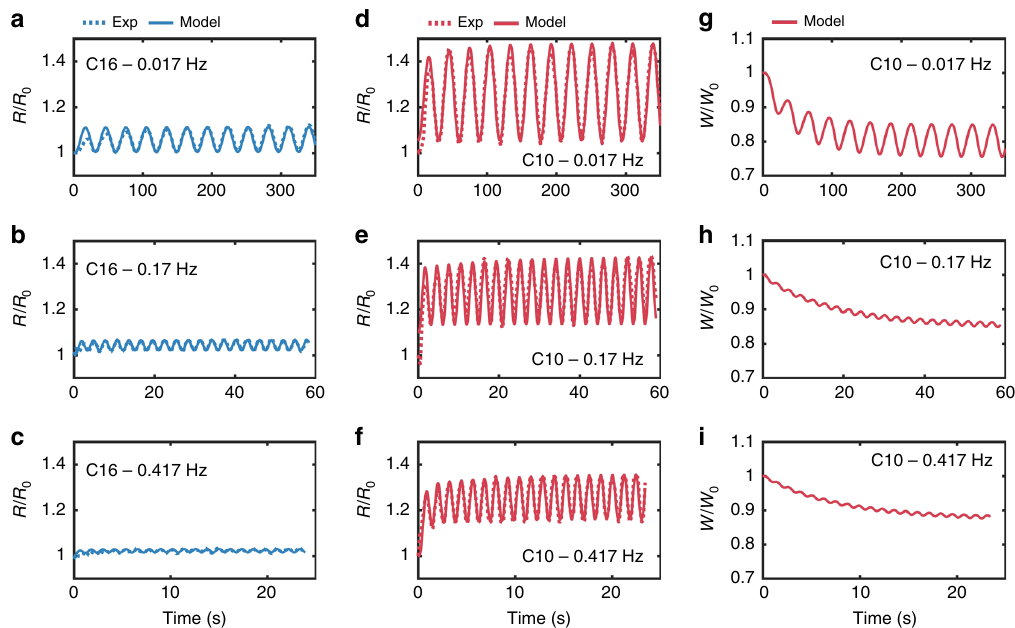
Fig. 6 Experimental and simulated changes in bilayer radius and thickness in response to sinusoidal voltage input. The fi rst two columns show measurements and simulated (obtained using Eq. 3) responses of dynamic changes in the radii of DPhPC membranes formed in both hexadecane ( a – c ) and decane ( d – f ) systems in response to sinusoidal voltages at three different frequencies. The third column ( g – i ) shows simulated (obtained using Eq. 4) dynamic changes in membrane thickness for a DPhPC membrane formed in decane. Experimental values of dynamic changes in thickness are not obtained; therefore, only simulated results are provided. Also, simulated changes in thickness of DPhPC bilayers in hexadecane are not included since quasi-static measurements show thickness to be constant (Supplementary Fig. 4)